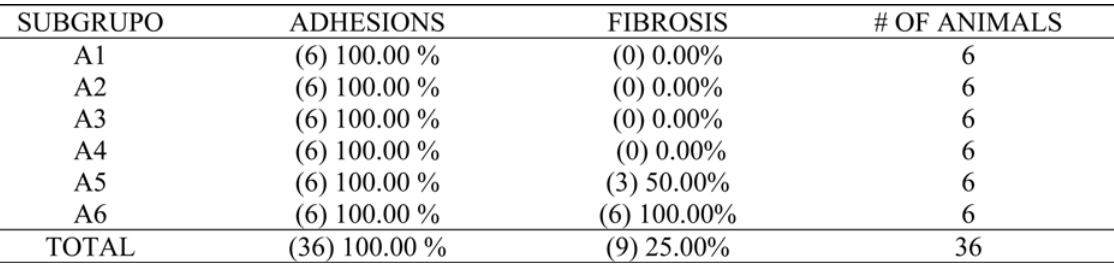
TABLE 3 - Microscopic finding on the hepatic hilum – presence of adhesions and fibrosis